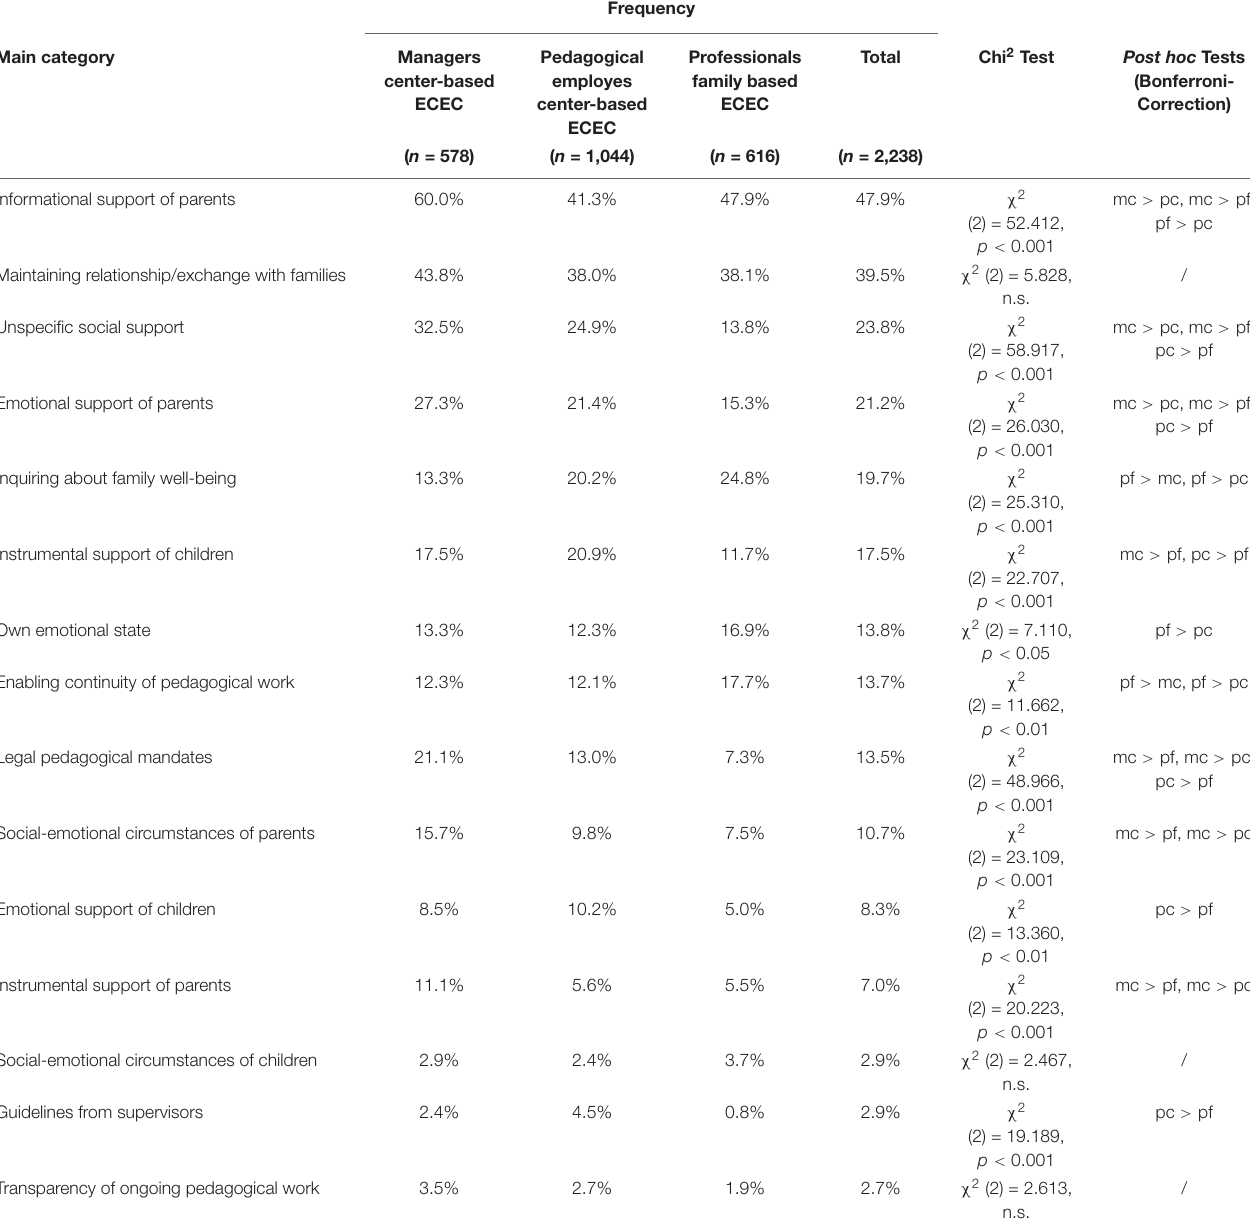
TABLE 3 | Main categories and their respective frequencies of reasons for being in contact with parents ( n =